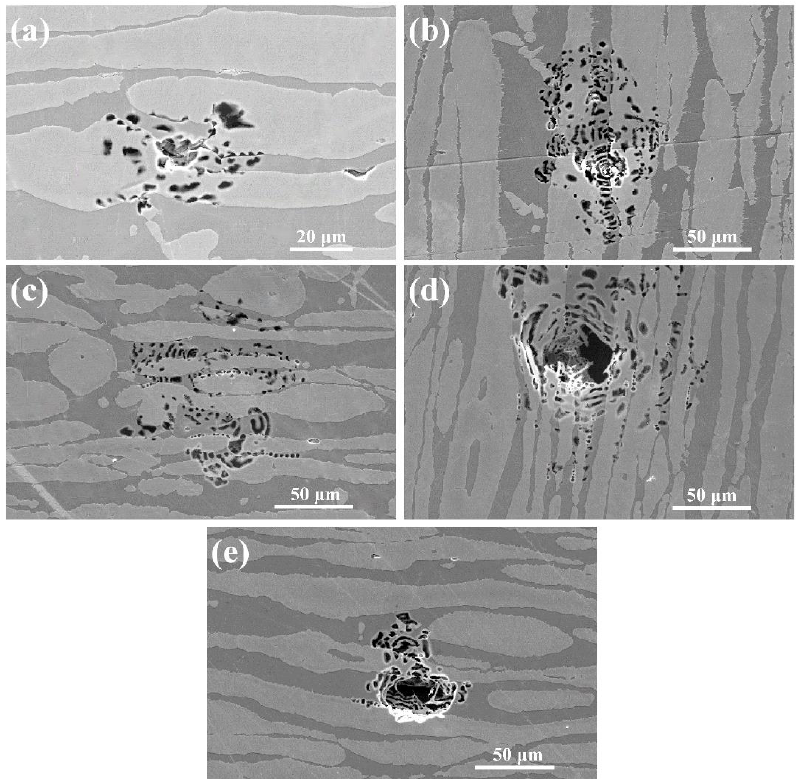
Figure 9. SEM morphologies of specimens with different cooling rates after the CPT tests: ( a ) 0.25 °C/s; ( b ) 1 °C/s; ( c ) 5 °C/s; ( d ) 10 °C/s; ( e ) 20 °C/s.